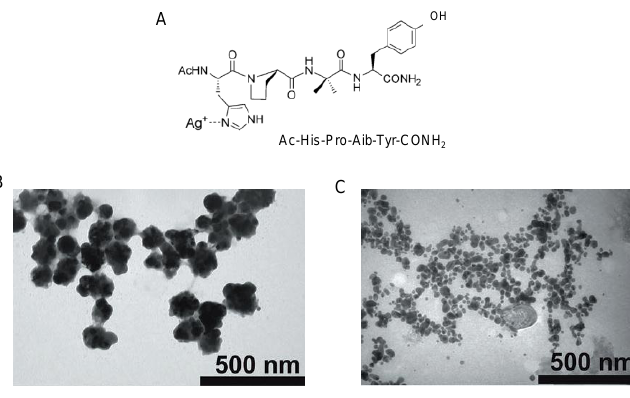
Figure 6. Synthesis of AgNPs. ( A ) Peptide structure; ( B , C ) TEM pictures Ag + -peptide complex after different irradiation times, t = 30 s and t = 30 min, respectively.